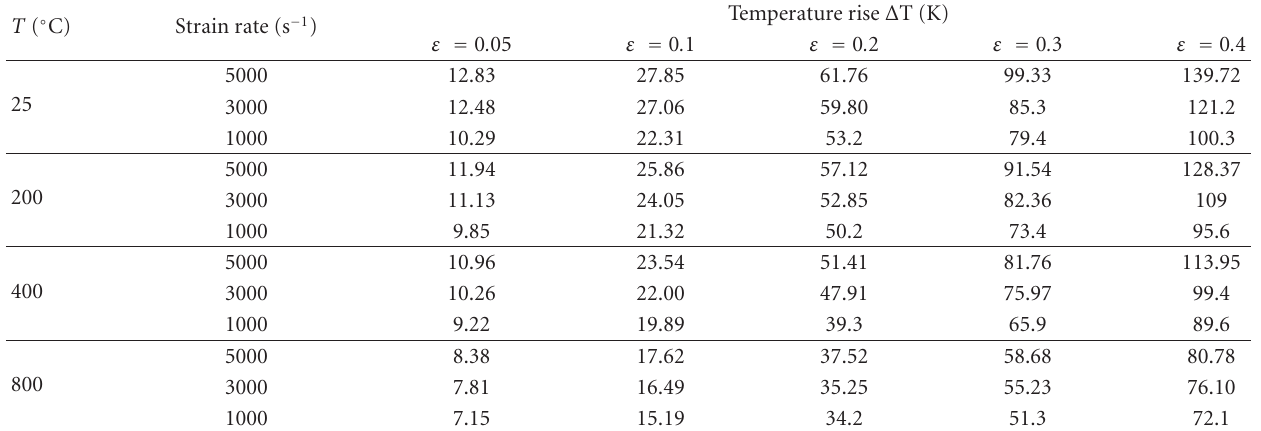
Table 6: Variation of deformation-induced temperature rise as function of temperature and strain rate. T ( ◦